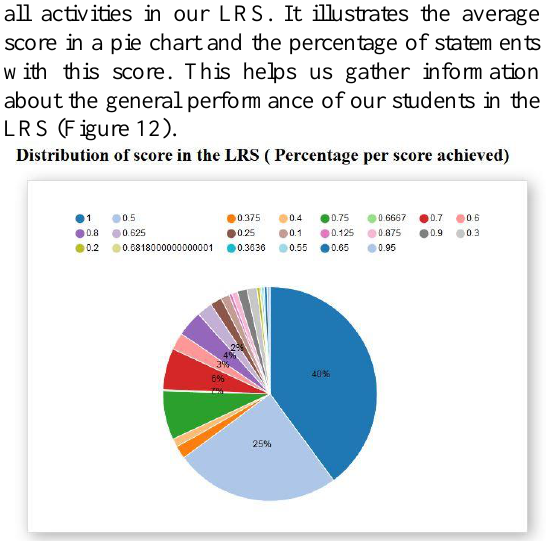
Figure 12. Average score in the